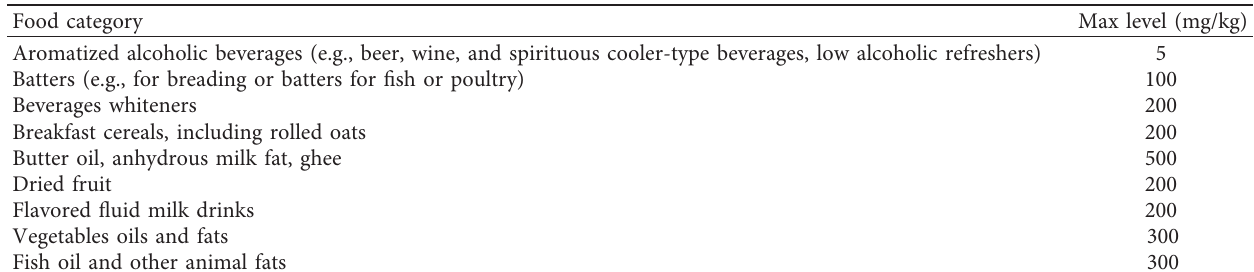
Table 2: Example of general standard for food additives’ provisions for tocopherols.